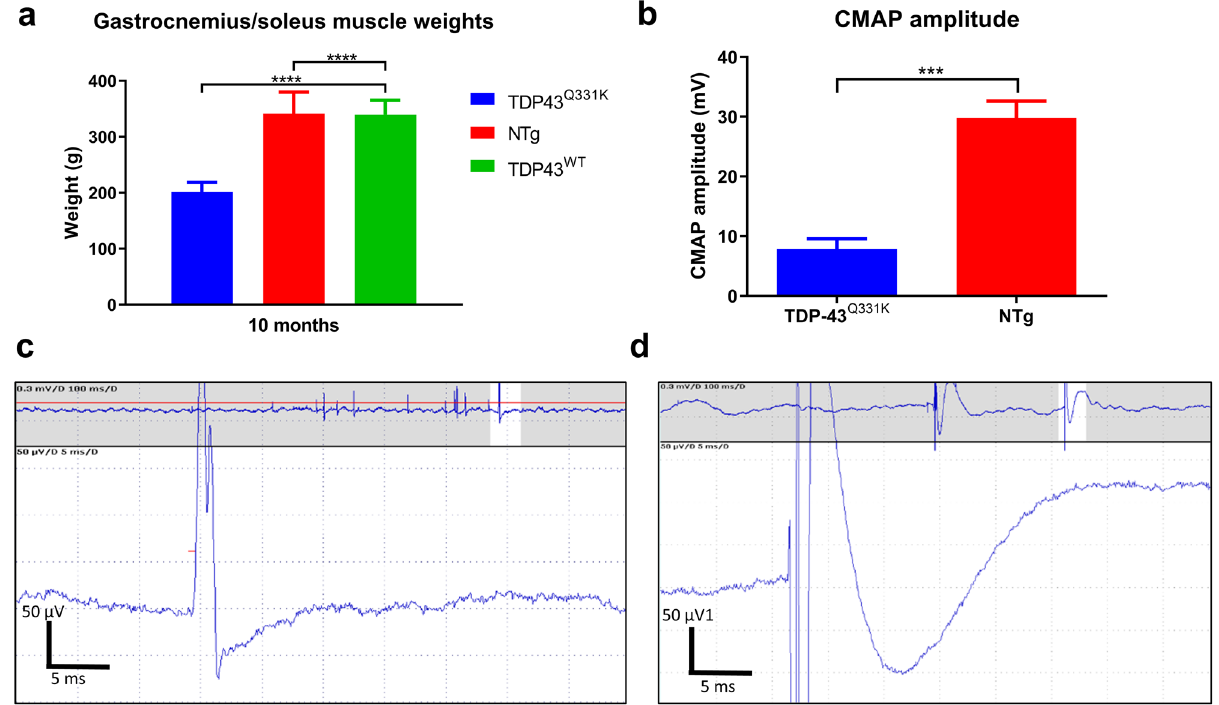
Figure 5. Muscle weights and electrophysiology. ( A ) Mean (± SD) gastrocnemius/soleus muscle weights of female mice at 10 months of age TDP-43 Q331K n = 10, NTg n = 12, TDP-43 WT n = 6. ( B ) Compound muscle action potential (CMAP) of the lower hindlimb of TDP-43 Q331K mice and non-transgenic mice (± SD) at 9–11 months of age (n = 3). *** p < 0.001 vs all other groups, **** p < 0.0001 vs other groups, one way ANOVA with Tukey’s post-tests. ( C , D ) Fasciculation potentials recorded in two out of eight TDP-43 Q331K mice tested. Such electrophysiological activity was not seen in TDP-43 WT mice. Mice were tested for CMAP and fasciculation at the same time